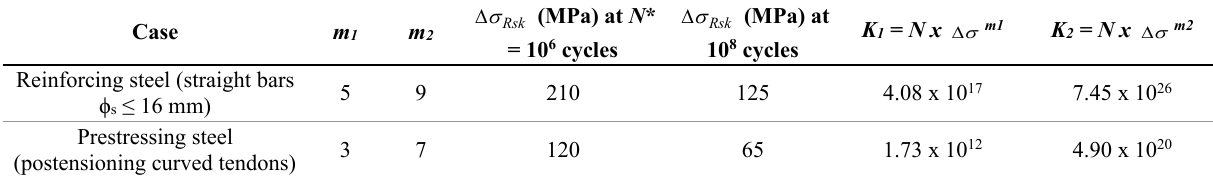
Figure 2. S-N curves for reinforcement (adapted from fib [14] and NBR 6118 [15]]). Table 1. Parameters of characteristic S-N curves from fib